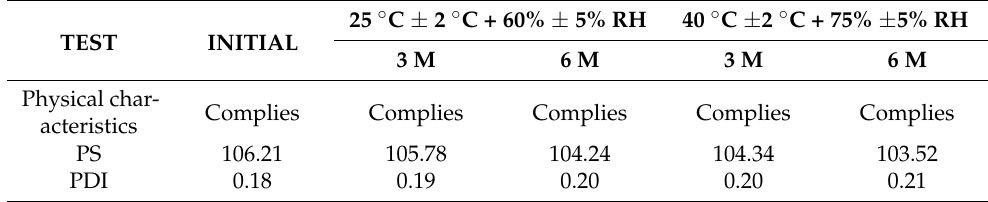
Table 5. Stability studies for